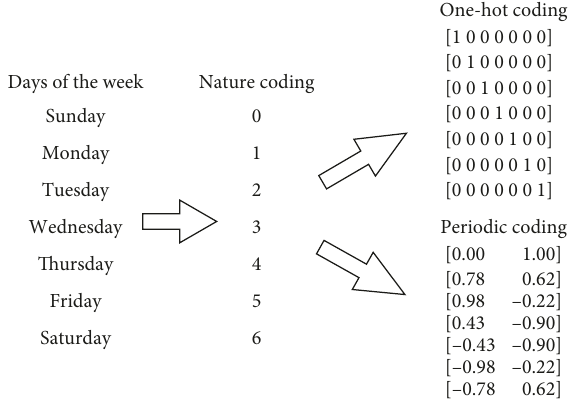
Figure 5: Coding method comparison by taking seven days of one week as an